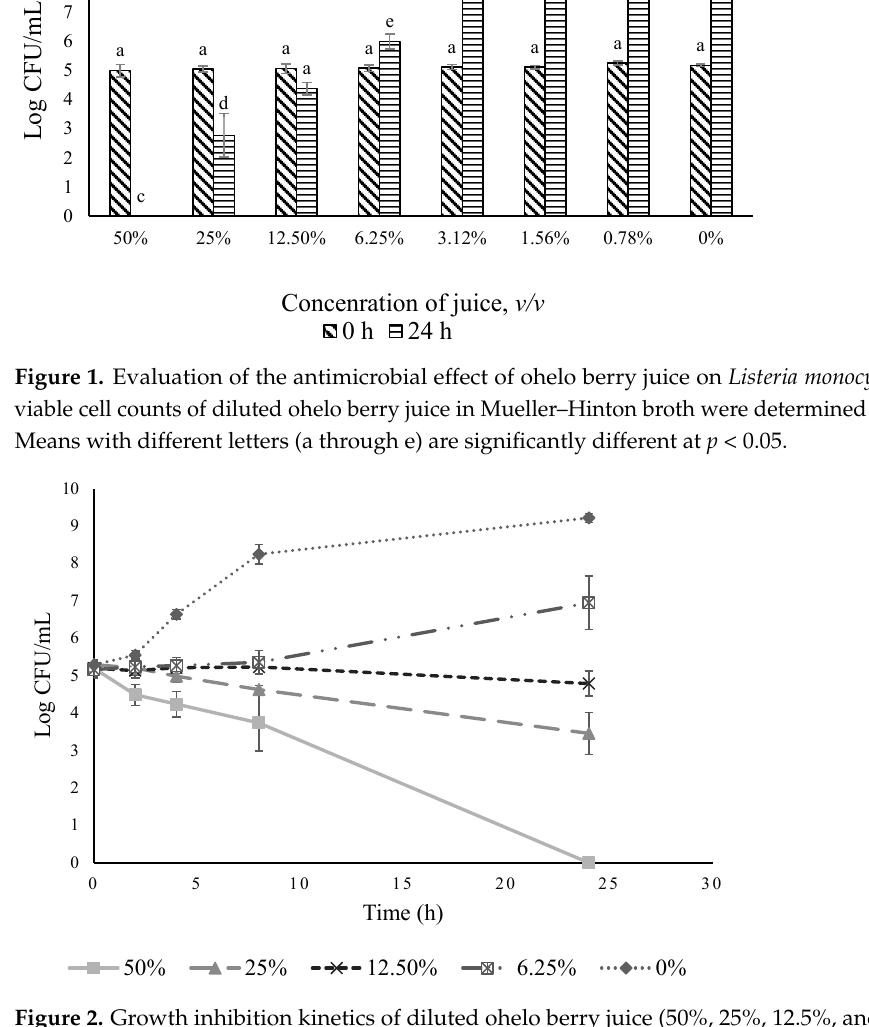
Figure 2. Growth inhibition kinetics of diluted ohelo berry juice (50%, 25%, 12.5%, and 6.25%) and control (0%) against Listeria monocytogenes in Mueller–Hinton broth.